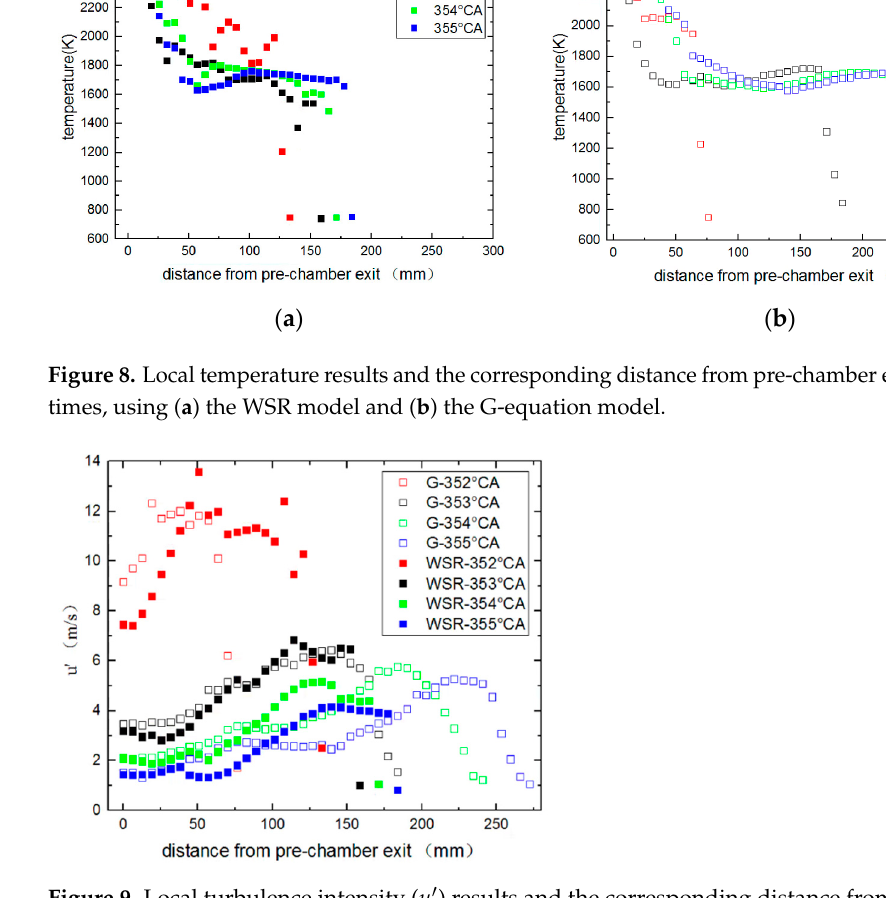
Figure 9. Local turbulence intensity ( 𝑢 (cid:4593) ) results and the corresponding distance from pre-chamber exit at different times, using the WSR model and the G-equation model.